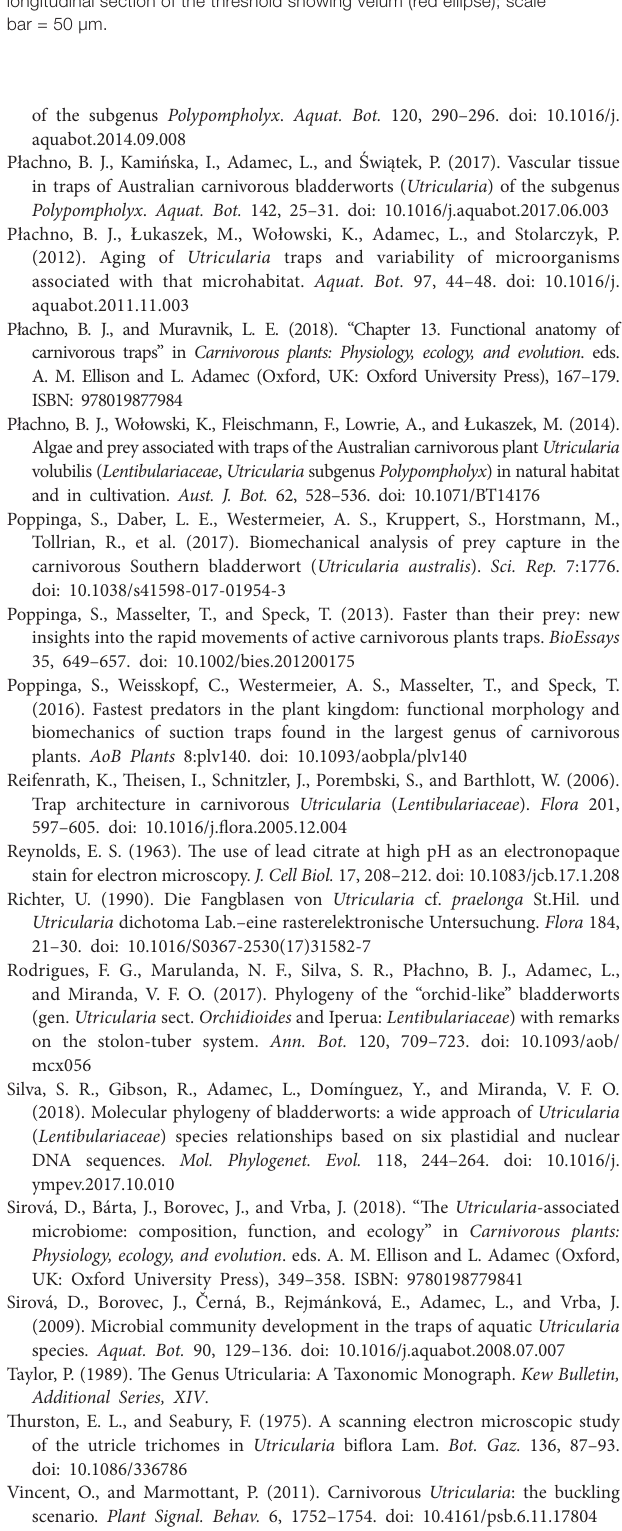
SUPPLEMENTARY FIGURE 1 | Comparison of Lloyd’s Utricularia trap (1942) drawings with our documentation; the same structures are marked by eclipses. (A) Section of Utricularia monanthos trap entrance; the outer velum (red ellipse), the inner velum (green ellipse). (B) Utricularia dichotoma , a semi- thin longitudinal section of the threshold showing the outer velum (red ellipse), the inner velum (green ellipse); scale bar = 50 μm. (C) Utricularia monanthos ,